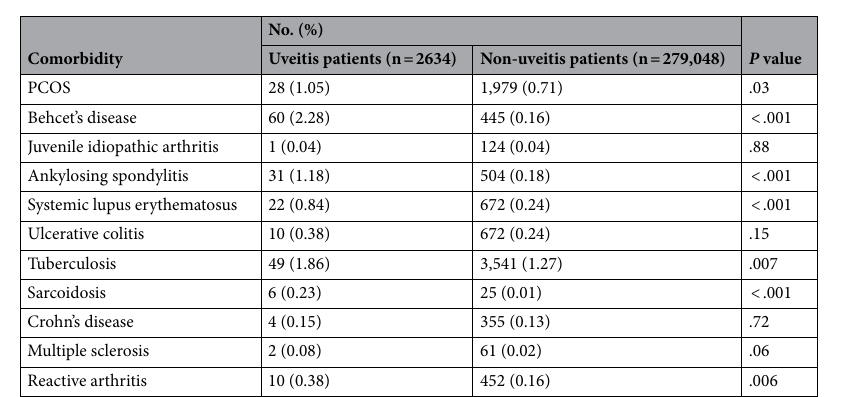
Table 3. Prevalence of comorbidities in women of reproductive age with or without uveitis. Data are presented as No. (%).